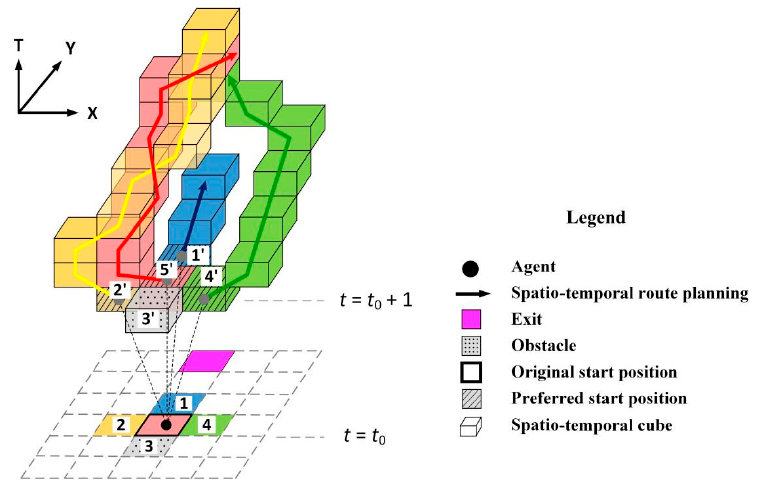
Figure 3. Alternative optimal spatio-temporal route set based on the preferred spatio-temporal neighbors.